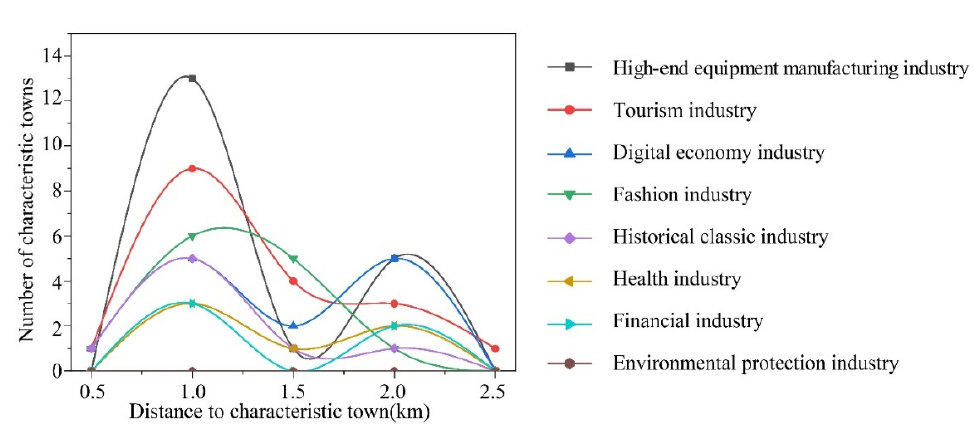
Figure 8. Gradient distribution of industrial types of characteristic towns.